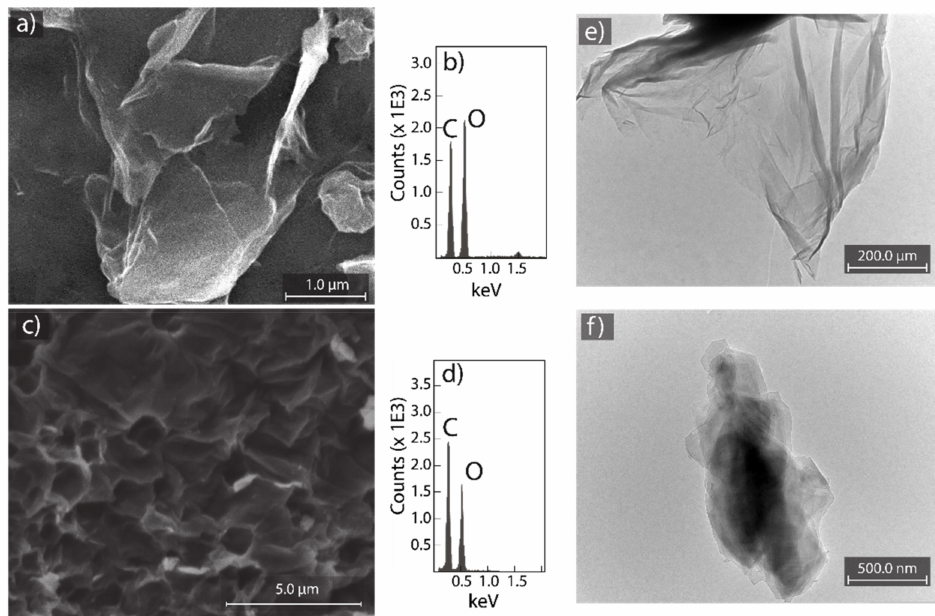
Figure 2. SEM morphology of ( a ) GO and ( c ) rGO. EDS measurements of ( b ) GO and ( d ) rGO. TEM images of ( e ) GO and ( f )